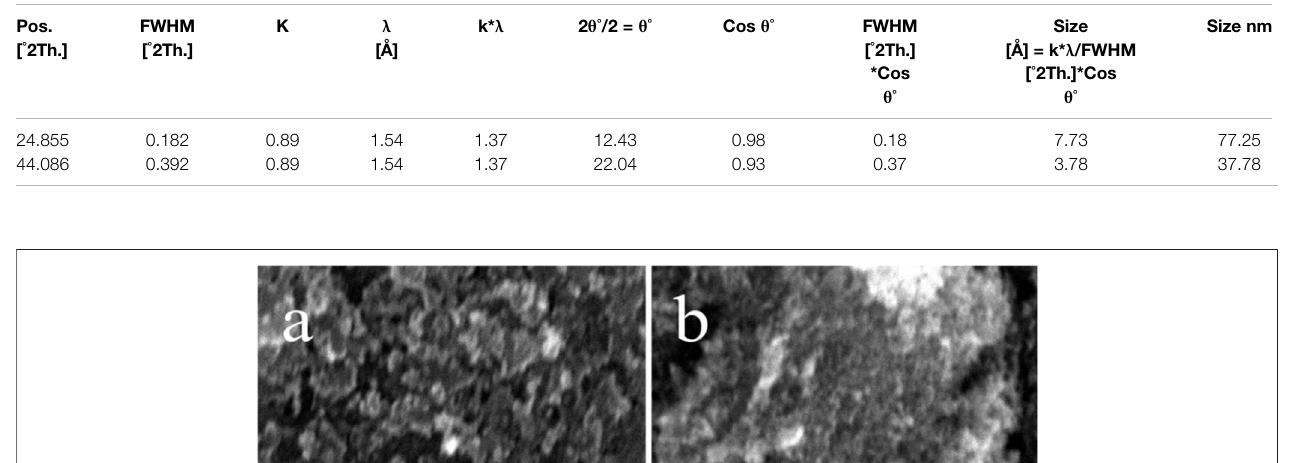
TABLE 3 | XRD spectral data for linseed oil. Pos. [ ° 2Th.]